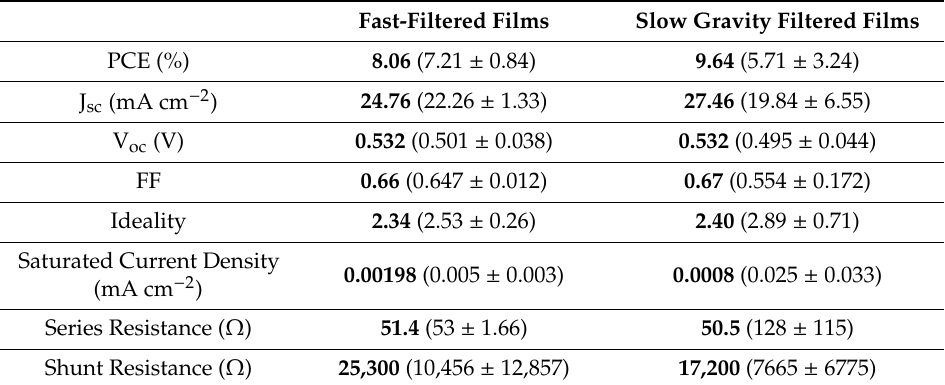
Figure 7. J/V properties for devices with slow and fast-filtered SWCNT films from 500 µL aliquots.